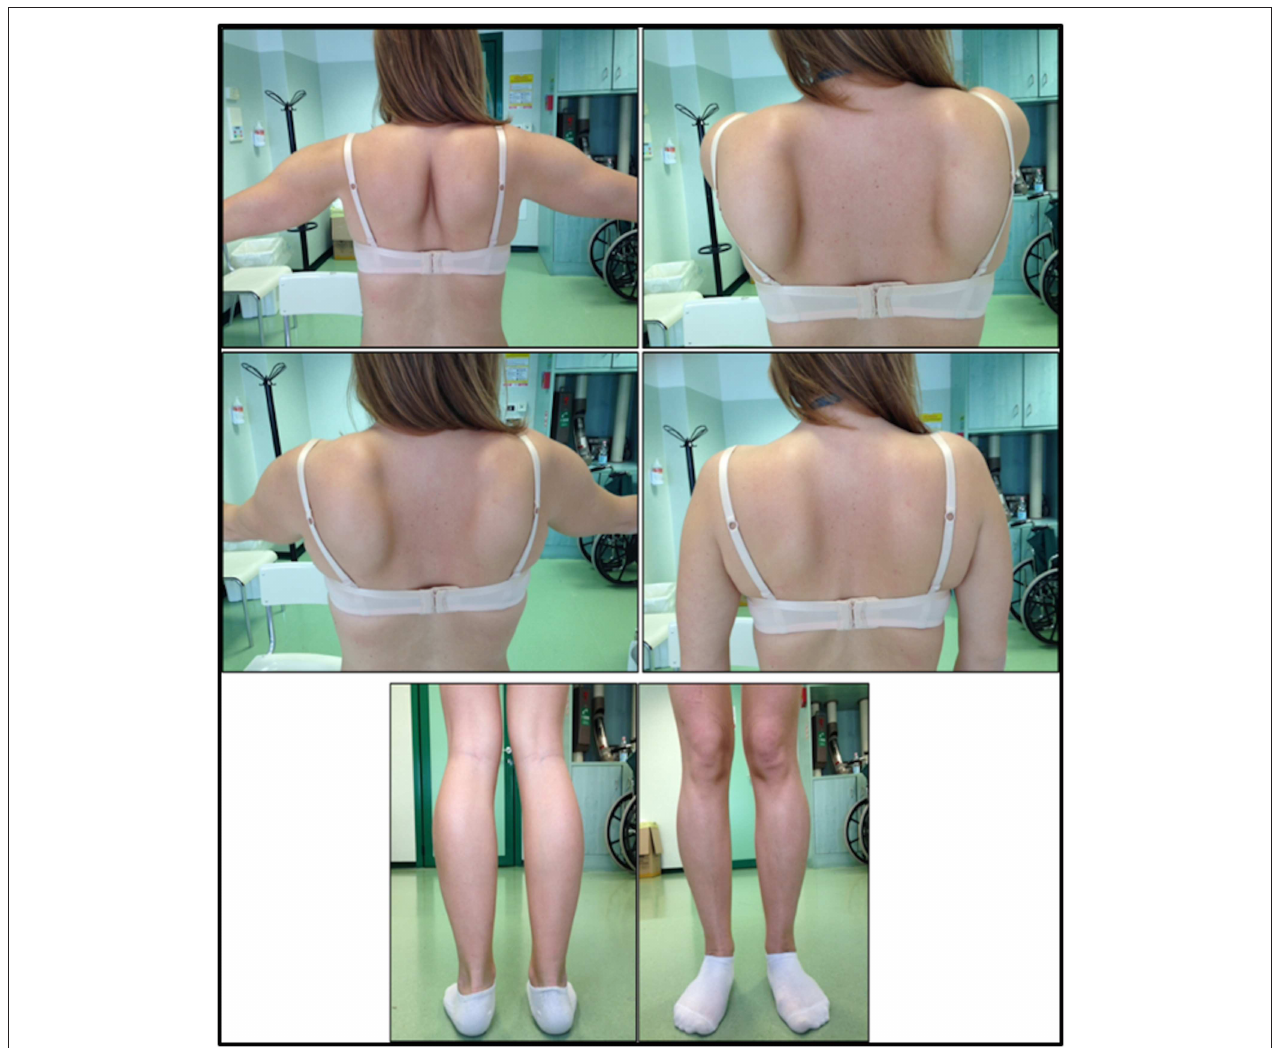
FIGURE 1 | Proband clinical features: winged scapulae and combination of thigh atrophy and calf pseudo-hypertrophy.